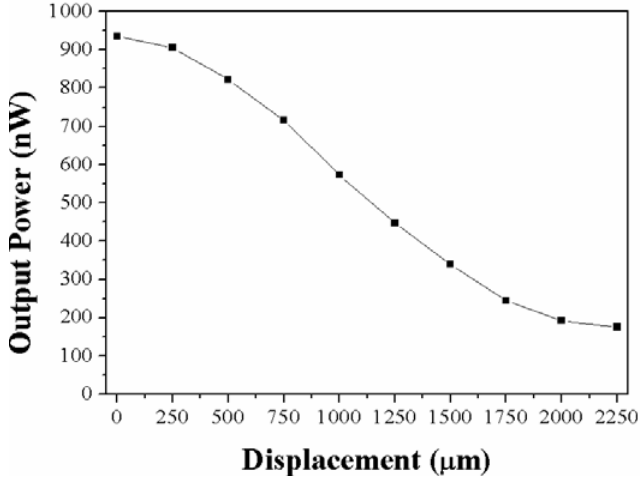
Figure 11. Output transmitted power as a function of displacement distance for a loop displacement sensor made with a 3 mm transition length, 30 mm waist length, and 35 μ m waist diameter of